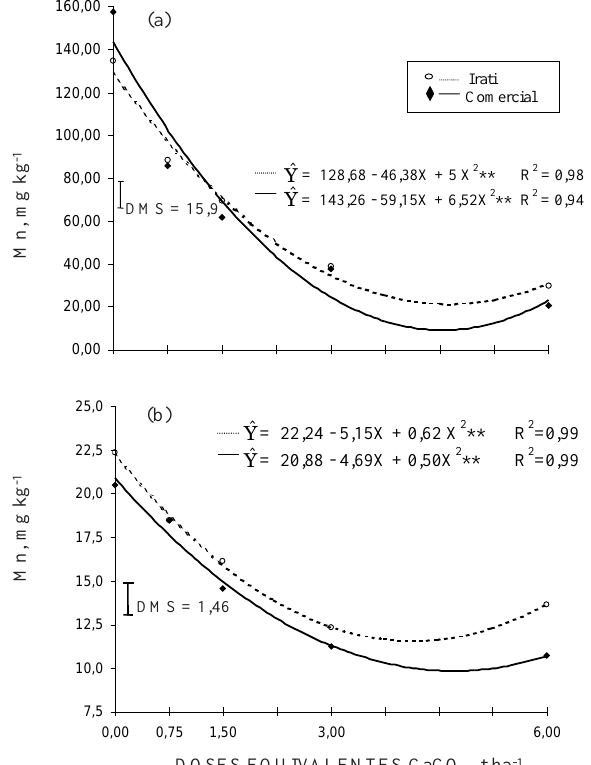
Figura 3. Concentração de Mn na planta de milho (a) e teores de Mn no solo extraído com DTPA- TEA (b) em função de doses crescentes de equivalentes de CaCO , e dos distintos 3 materiais corretivos. (DMS: Diferença mínima significativa para diferentes materiais corretivos a uma mesma dose).